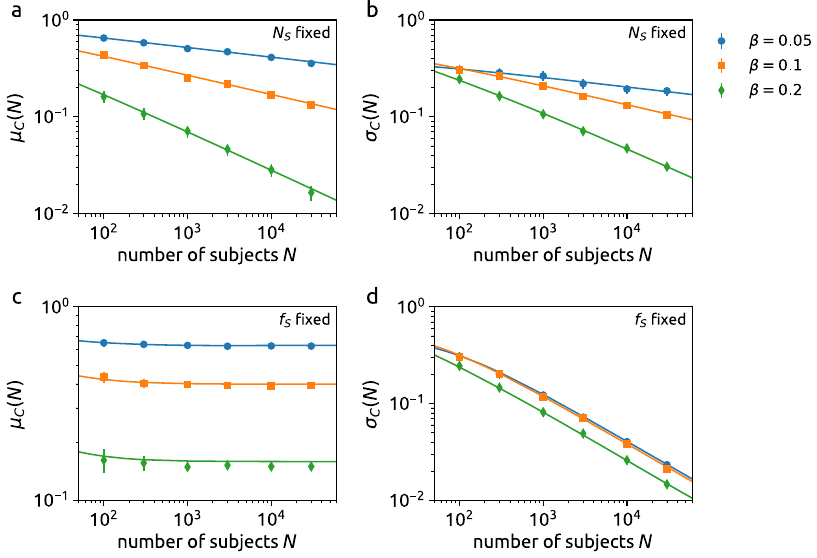
Fig. 3 Scaling of opinion consistency in synthetic worlds. Mean opinion consistency, μ C , and the standard deviation of consistency, σ C , as functions of the number of subjects, N , for regular random networks with node degree z = 50 and various levels of structural noise, β . The symbols and error bars show the mean and three times the standard error of the mean, respectively, obtained by running the model on 1000 network realizations. The solid lines show μ C ( N ) and σ C ( N ) obtained by solving the master equation (Eq. (6) and Eq. (S6) in the SI). a , b Results for a single seed opinion. In this scenario, both μ C and σ N grows: There is a tension between opinion consistency and the world ’ s complexity. c , d Results for a fi xed fraction of seed C converge to zero as opinions, f S , when the number of seed opinions is N S = f S N ; here f S = 0.01. In this scenario, the tension between consistency and complexity is prevented: μ C converges to f 2 β S ( c ) and σ C converges to zero ( d